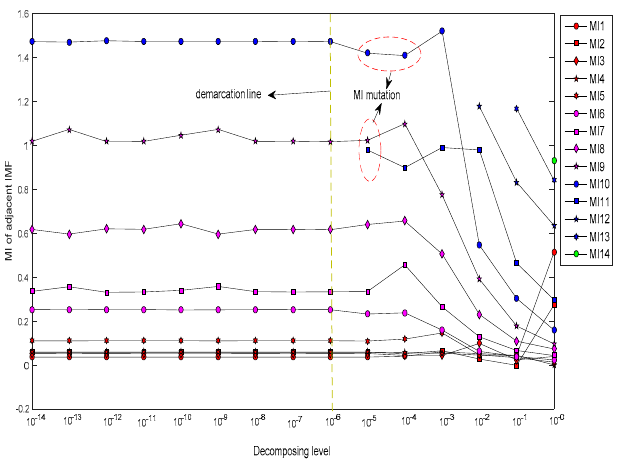
Figure 21. Decomposition result for a vibration signal with an inner raceway fault.